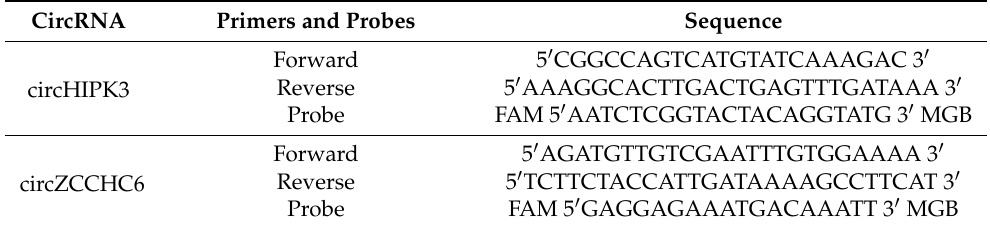
Table 2. Primer and probe design for circRNA validation by RT-qPCR.